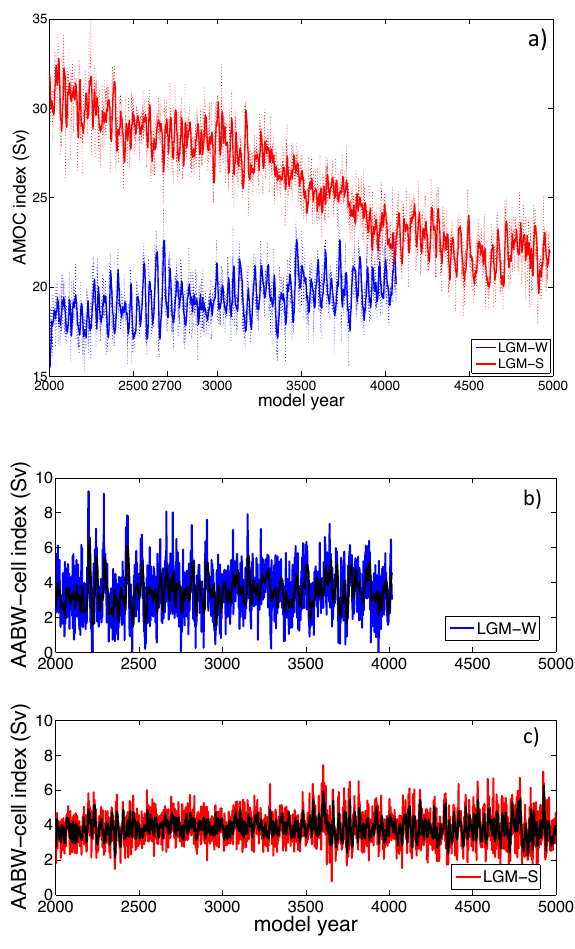
Fig. 2. AMOC indices with respect to (a) NADW-cell (defined as Figure 2 AMOC indices with respect to a) NADW-cell (defined as the the maximum value of stream function below 500m in the North maximum value of stream function below 500m in the North Atlantic) and Atlantic) and (b–c) AABW-cell (defined as the maximum of abso- lute value of stream function below 2500m along 30 ◦ S) for LGMS b-c) AABW-cell (defined as the maximum of absolute value of stream (red) and LGMW (blue). The bold solid lines are the 10yr running mean. Units: Sv=10 6 m 3 s − 1 . function below 2500m along 30 S) for LGMS (red) and LGMW (blue). The bold solid lines are the 10-year running mean. Units: Sv.